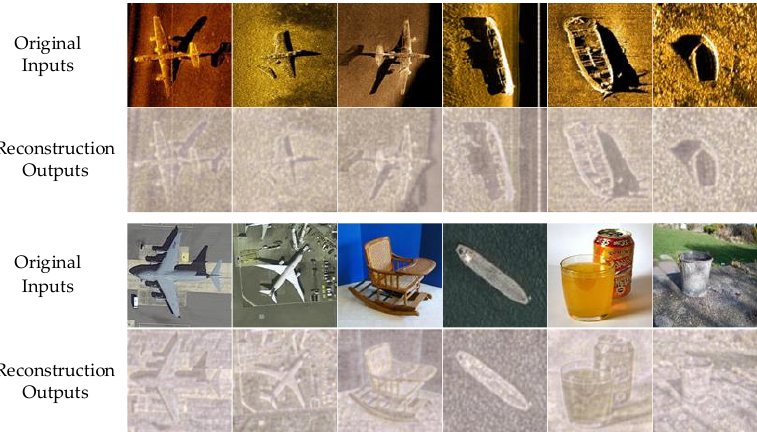
Figure 8. Decoded results of the polluted whitened features; the inputs are the same as in Figure 6.